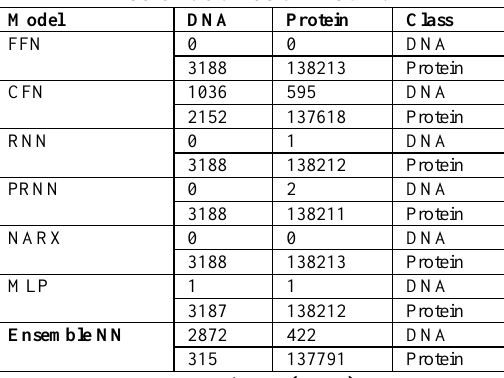
Table 2: Confusion